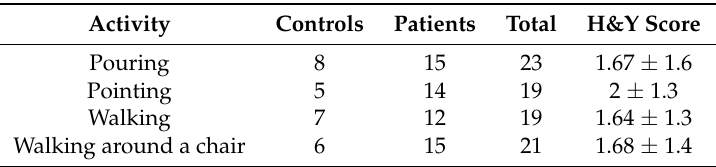
Table 1. Dataset: number of